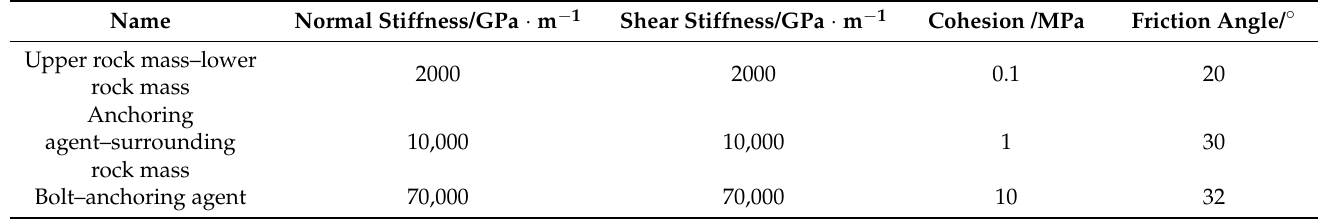
Table 3. Mechanical parameters of contact